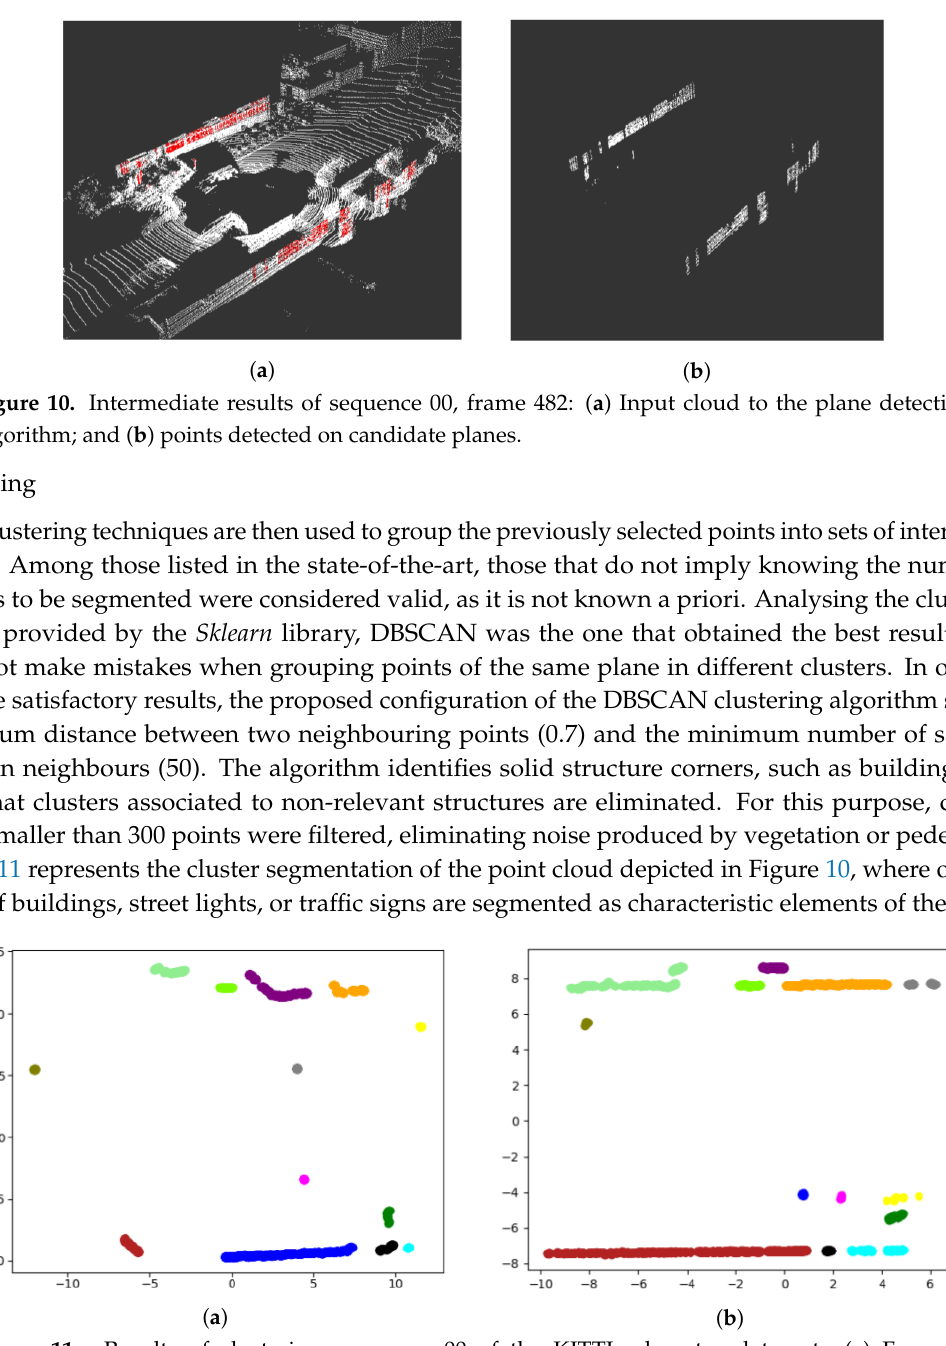
Figure 11. Results of clustering, sequence 00 of the KITTI odometry data set: ( a ) Frame 0, and ( b ) Frame